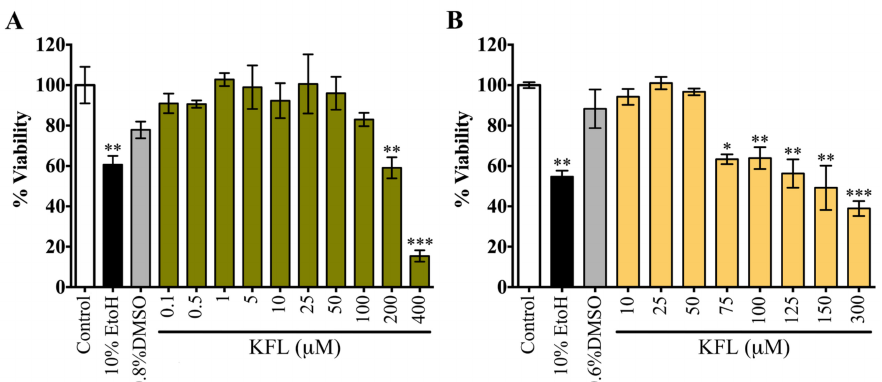
Figure 1. Cytotoxicity of kaempferol. The cytotoxicity of kaempferol was evaluated by using MTT assay. Results are presented as percentage of cell viability from four replicates at 24 h post treatment. ( A ) HEK293T / 17 cells and ( B ) BHK-21 cells were treated with various concentrations of kaempferol in parallel with the corresponding percentage of DMSO. Negative (10% FBS in DMEM) and positive (10% EtOH) controls were included. Error bars represent mean ± SD *; p value < 0.05, **; p value < 0.01 and ***; p value < 0.001. All statistics were determined by comparison with the DMSO control.